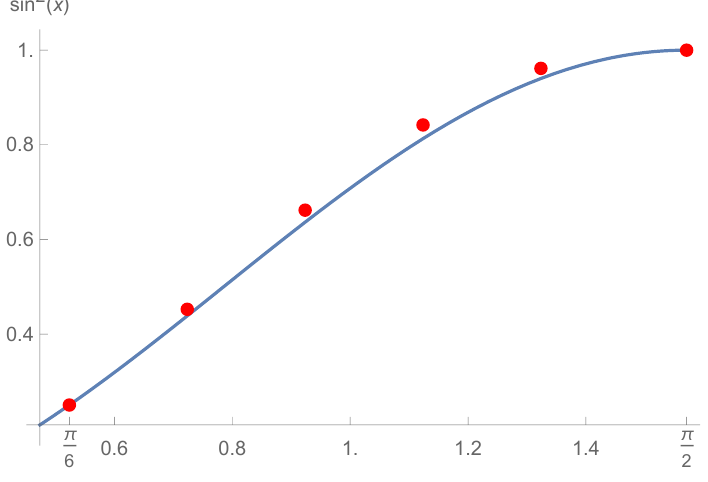
Figure 5. An ODE boundary value problem for Example